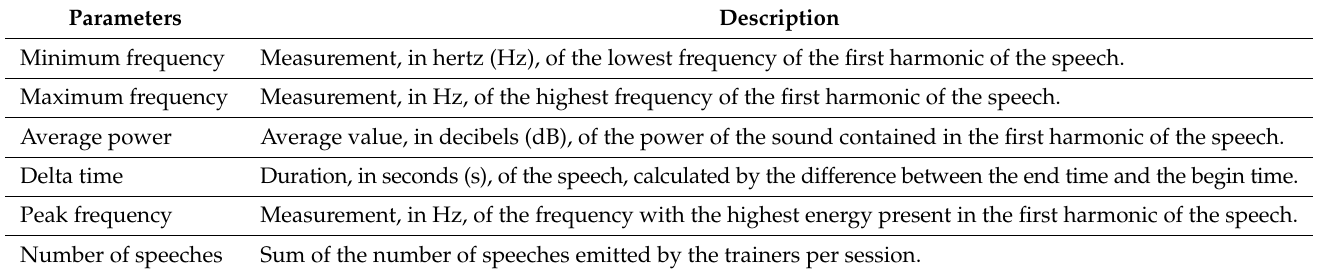
Table 4. Description of the acoustic variables used to characterize the trainers’ vocalizations extracted from videos from training sessions with socialized dogs ( Canis familiaris ) and wolves ( Canis lupus